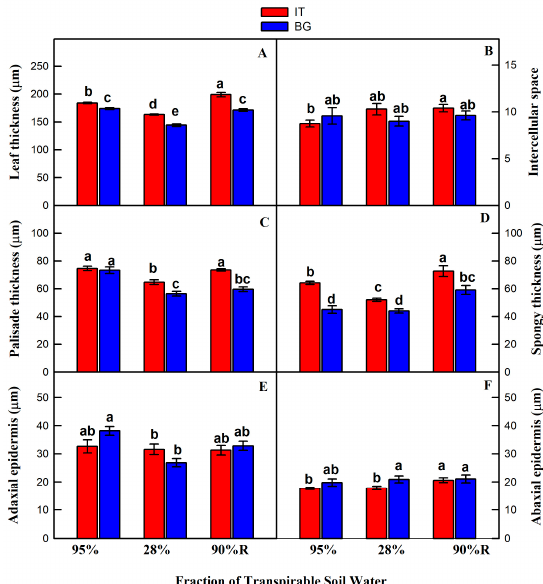
Figure 1. Leaf structural traits in Italian (IT, red bars) and Bulgarian (BG, blue bars) populations of Platanus orientalis plants under control (fraction of transpirable soil water (FTSW) = 95%) and drought (FTSW = 28%) conditions and after re-watering (FTSW = 90%R). ( A ) Leaf thickness; ( B ) relative area of mesophyll occupied by intercellular space; ( C ) palisade thickness; ( D ) spongy thickness; ( E ) adaxial epidermis; ( F ) abaxial epidermis. Data are means ± SE of six independent samples. Statistically significant differences (Tukey’s test, p < 0.05) between the IT and BG ecotypes are indicated by different letters.